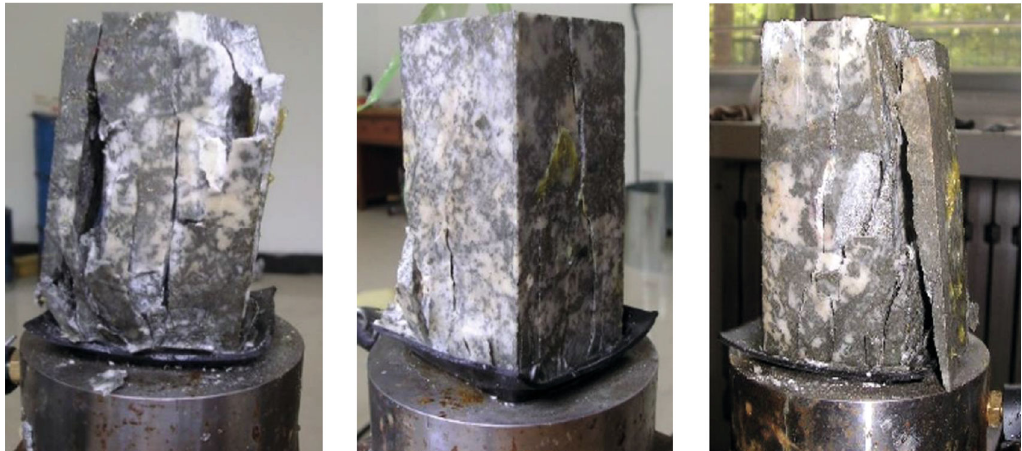
Figure 6: Failure patterns of the specimens under compression tests with the seepage.